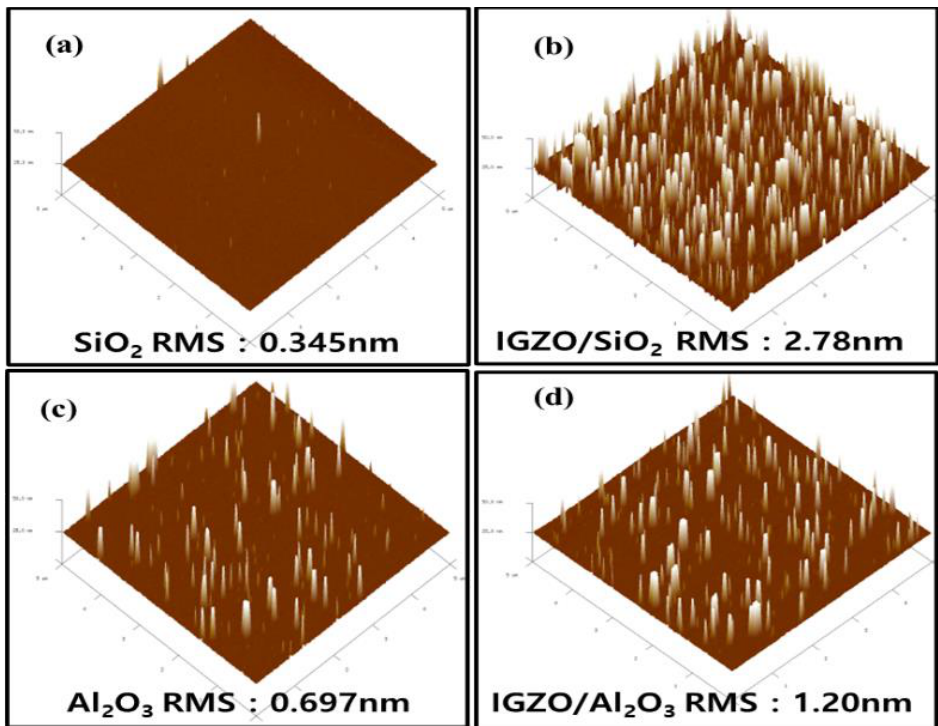
Figure 2. AFM images of ( a ) SiO 2 , ( b ) IGZO on SiO 2 , ( c ) Al 2 O 3 , and ( d ) IGZO on Al 2 O 3 where SiO 2 and Al 2 O 3 serve as the TNL in the TFT flash memory device.